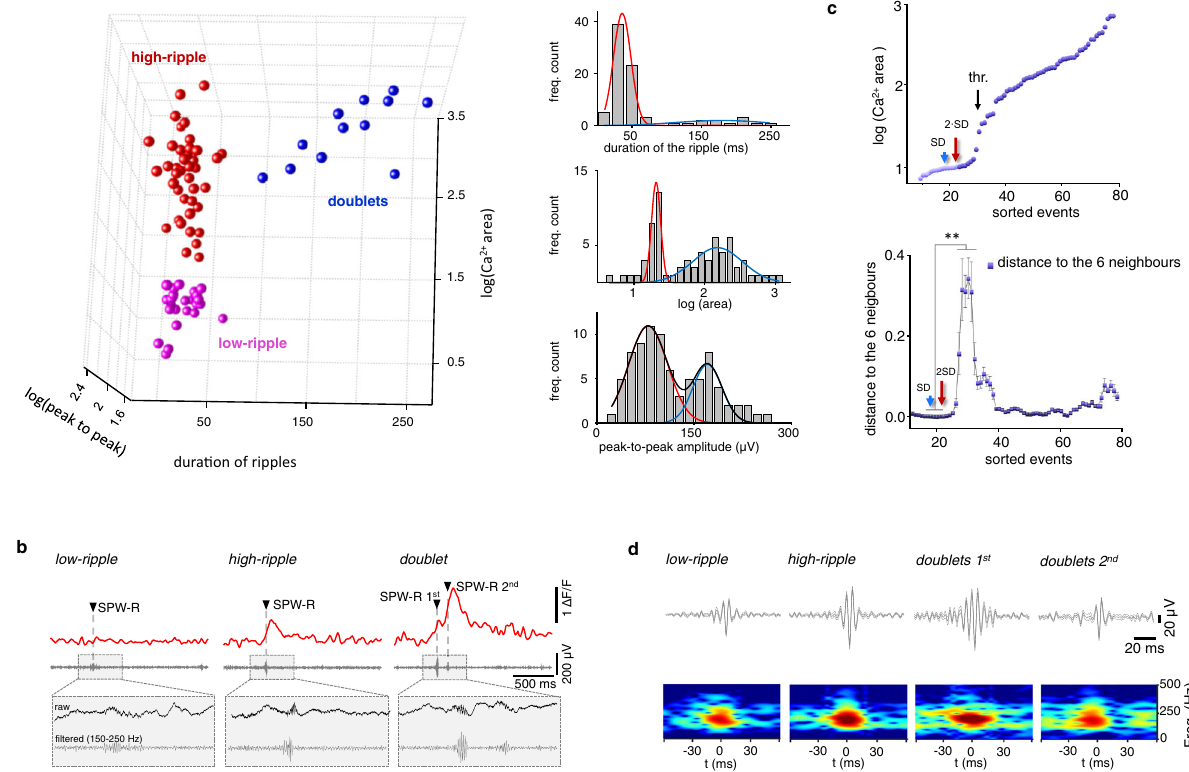
Fig. 3 | Separation of the three different types of SPW-R-associated activity. a Left, SPW-R-associated events plotted asa function of duration and peak-to-peak amplitudes of ripples and Ca 2+ areas of SPW-R events (low-ripple: magenta, high- ripple: red, doublets: blue). Both the Ca 2+ area and the peak-to-peak amplitude underwent logarithmic transformation. Right, spectral quanti fi cation of the three parameters shown in the left panel. Top right, frequency count of the ripple event durations separated doublets from the high-ripple+low-ripple groups. Frequency counts were fi tted with two Gaussian distributions corresponding to the doublets (blue)andthehigh-ripple+low-ripples(red)groups.Notethegapbetweensinglets and doublets. Middle right, same as top right panel but for Ca 2+ areas following logarithmic transformation. The Peak Analyzer module (Origin Pro, OriginLab) identi fi edtwoGaussiandistributions( χ 2 =1.28,adj. R -Square=8.30 ∙ 10 − 1 ,SS=24.35) corresponding to the low-ripple (red) and the high-ripple+doublet (blue) groups. Bottom right, frequency count of peak-to-peak amplitude. The Peak Analyzer module identi fi ed two Gaussian distributions ( χ 2 =1.49, adj. R -Square=8.64 ∙ 10 − 1 , SS=16.38): the low-ripples (red)and high-ripples+doublets(blue).The blacktrace